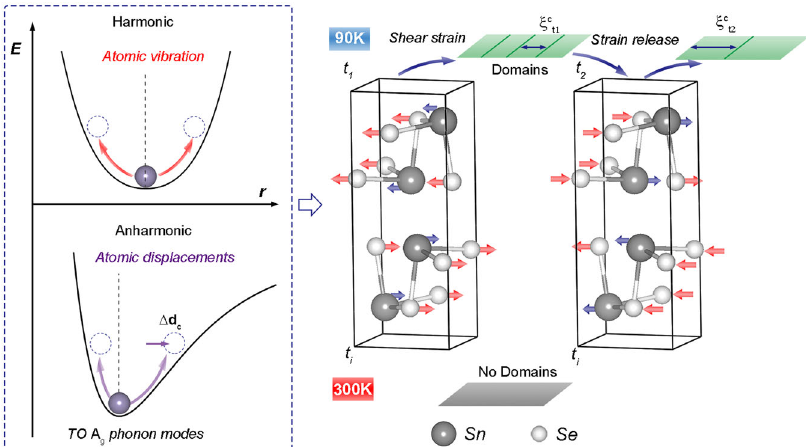
Fig. 5 Photoinduced domain formation in SnSe. After photoexcitation, the electrons are ‘ heated ’ into excited states. During electron excitation and relaxation processes, via energy fl owing from electrons to phonons, in the harmonic energy potential, the atom vibration near the equilibrium position is enhanced, which increases the instability of the lattice periodicity. Additionally, the transverse optical (TO) A g phonon modes are excited through electron – phonon coupling, atoms deviate from the original positions along c axis ( Δ d c ). There are four A g phonon modes in the b – c plane in SnSe. At 90 K, the direction of atomic displacements dominates at different delay times. The incompatibility (cid:1) (cid:3) reduces the correlation length ξ c generates domains driven by the shear strain between layers. The strain release drives the atoms move to t 1 the opposite direction, which gradually increases the correlation length ξ c t 2